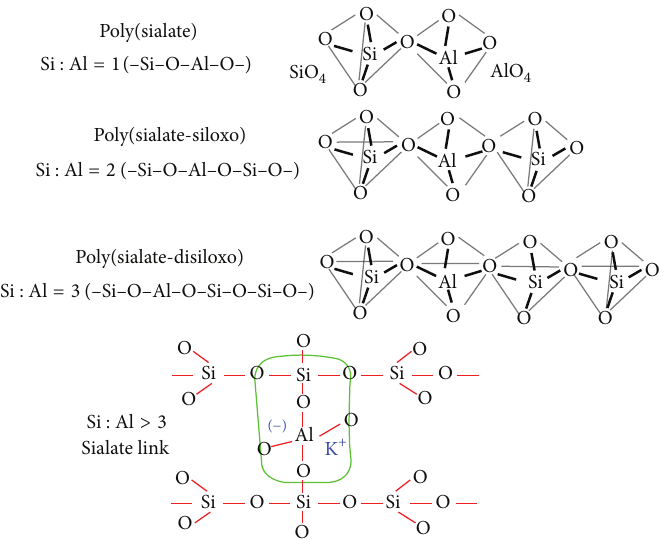
Figure 1: Geopolymer terminology [11].